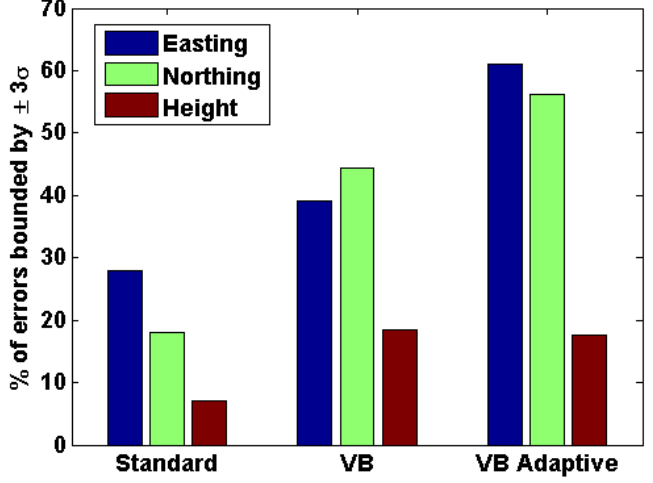
Figure 11. Reliability of position solution (OEM6+IMU)—urban canyon.